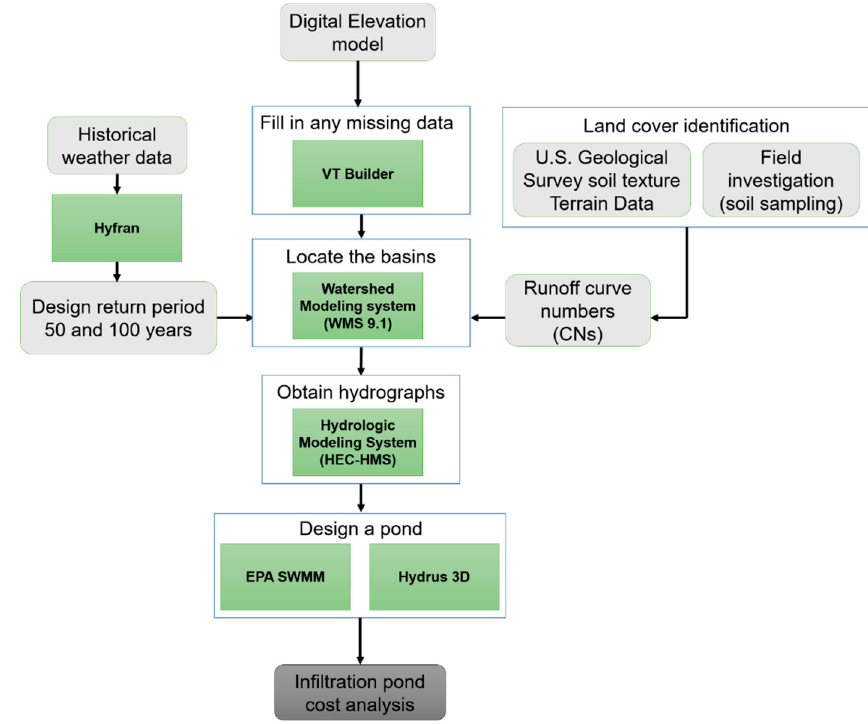
Figure 4. Flowchart of the integrated software used in this study.